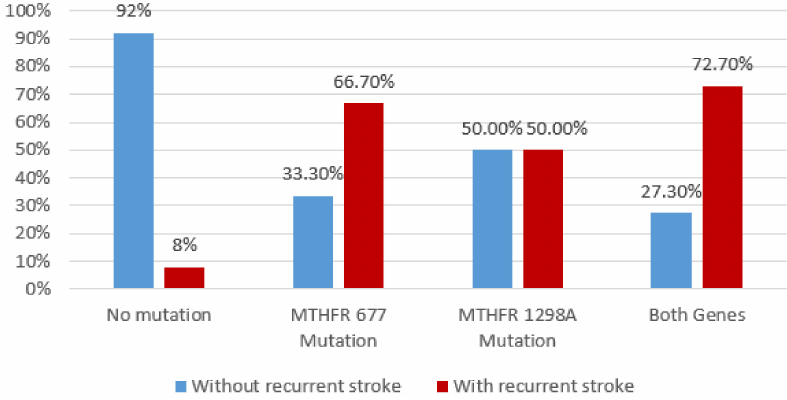
Figure 8. Association between recurrent stroke and MTHFR polymorphisms by Chi 2